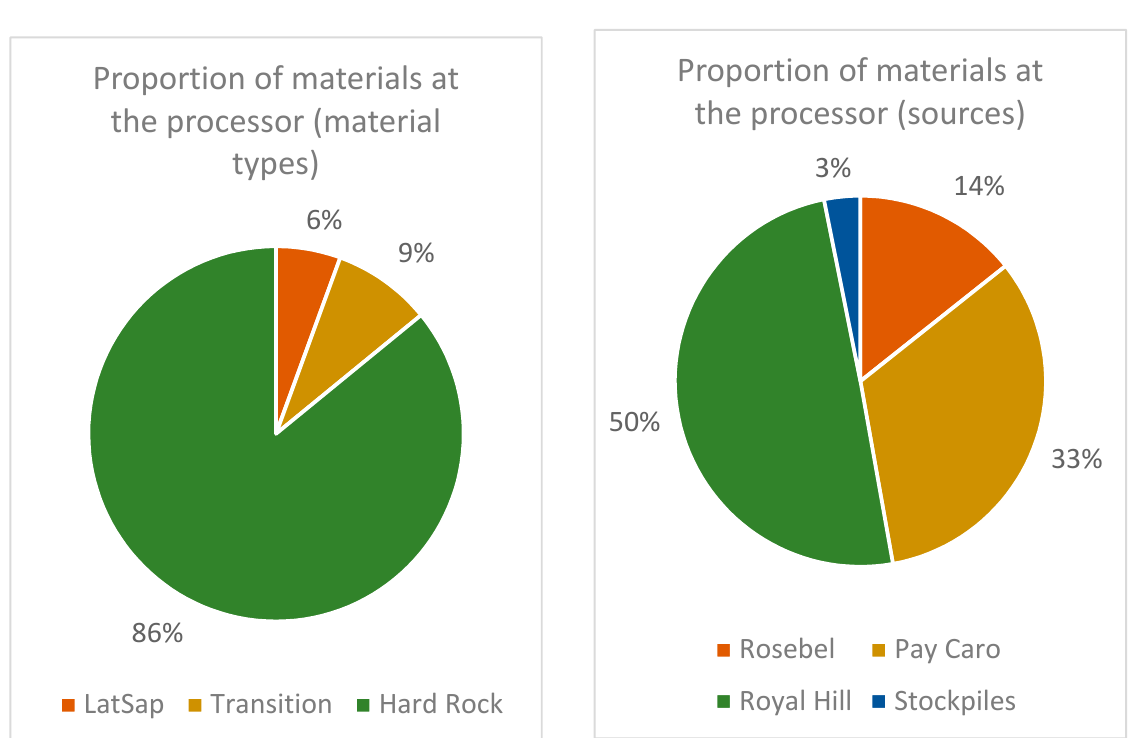
Figure 12. Proportion of different material types ( left ) and material from different sources ( right ) at the processor.